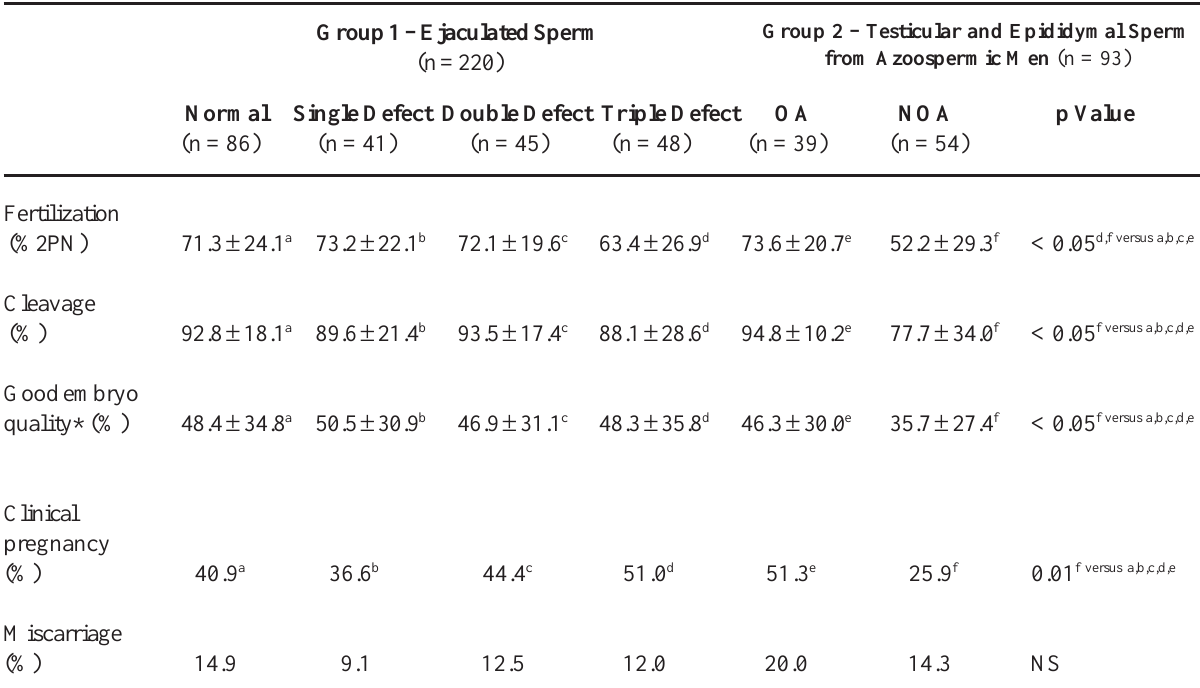
Table 2 – ICSI outcomes with ejaculated sperm with and without sperm defects, and with epididymal and